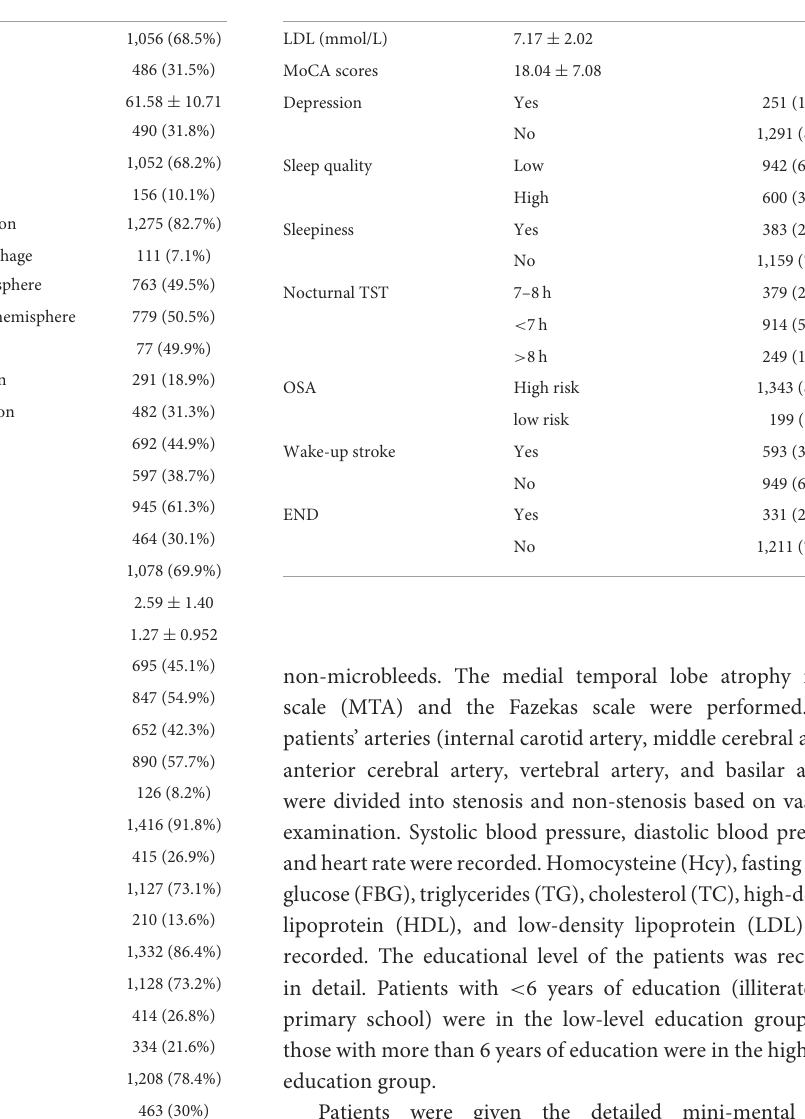
TABLE 1 Basic information of all